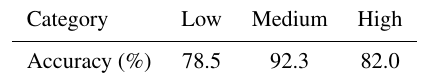
Table 8. Prediction model accuracy.